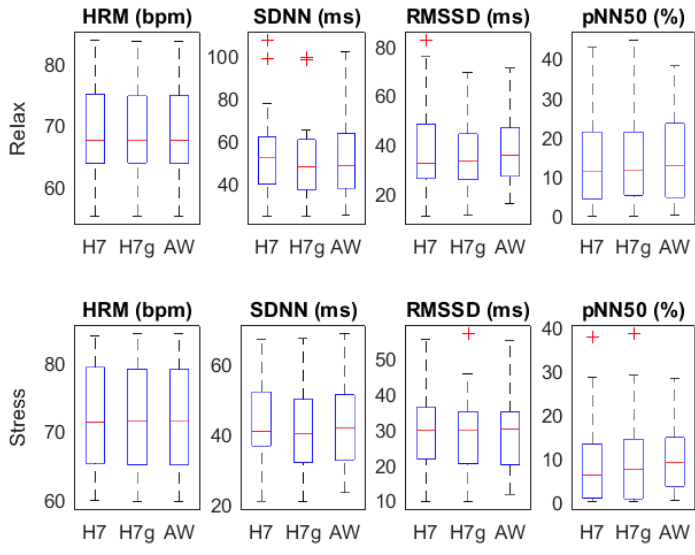
Figure 3. Heart rate variability (HRV) parameters: time domain.